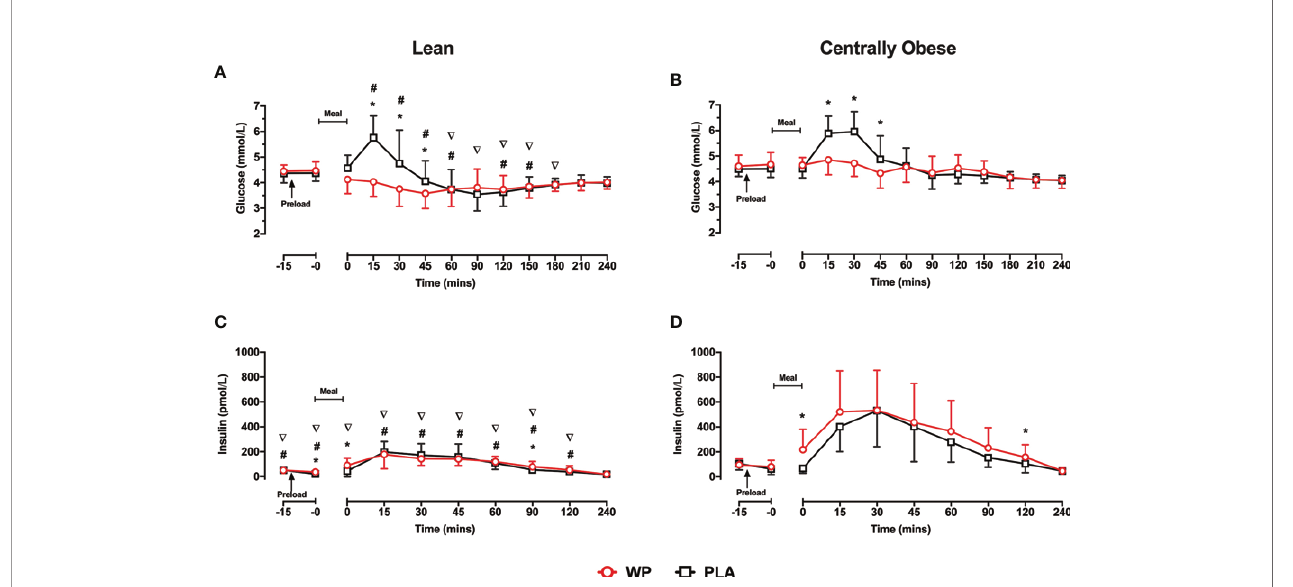
FIGURE 1 | Mean ± SD time-course changes in plasma glucose (A , B) and insulin (C , D) , following pre-meal consumption of a WP ( red ) and PLA preload ( black ) in lean (A , C) and centrally obese (B , D) males. Pre-meal treatments were administered 10 min before breakfast (t = − 10 min), as indicated by the arrow on the fi gure. The mixed-nutrient meal was served at t = − 0min and was to be consumed within 15 min. Time-course glucose data were analysed by a mixed-model ANOVA with repeated measures (time and treatment). Time-course insulin data were analysed by a Friedman ’ s ranks test with pairwise comparison. Between-group differences in postprandial insulin were assessed by a Kruskal – Wallis H test. *Denotes a within-group treatment effect (i.e., WP vs PLA). # denotes between-group differences (i.e., lean vs centrally obese) during the WP trial. ∇ denotes between-group differences during the PLA trial. Statistical signi fi cance was accepted as p